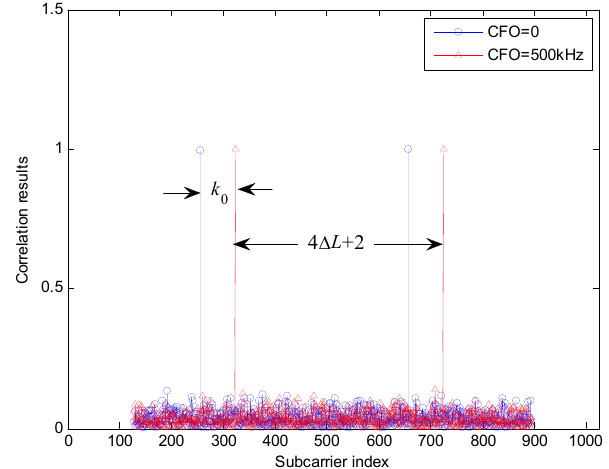
Figure 5. Frequency–domain correlation results with signaling and different integer